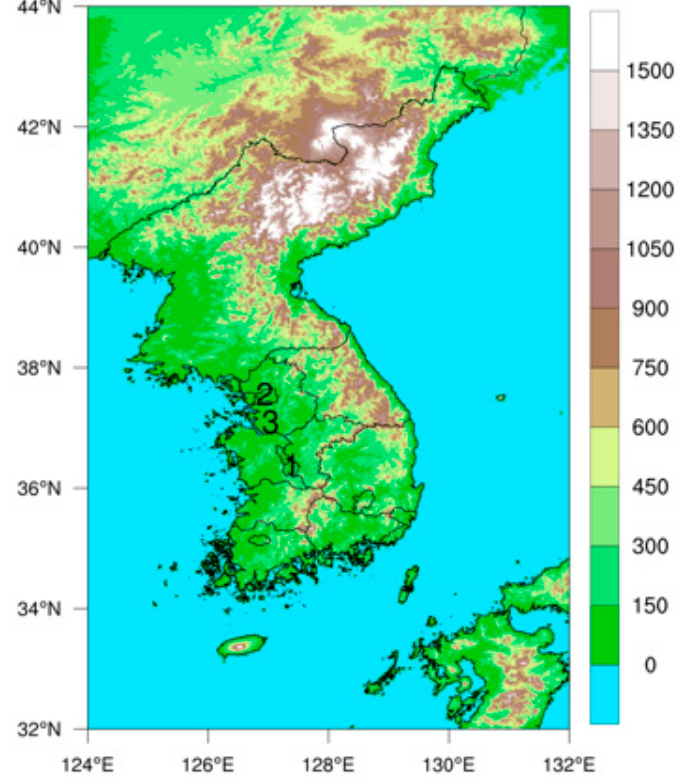
Figure 1. Topography of area over which satellite-derived solar irradiance was obtained. Numbers 1, 2, and 3 indicate the locations of the Korea Institute of Energy Research (KIER), Yonsei University, and Osan stations, respectively.